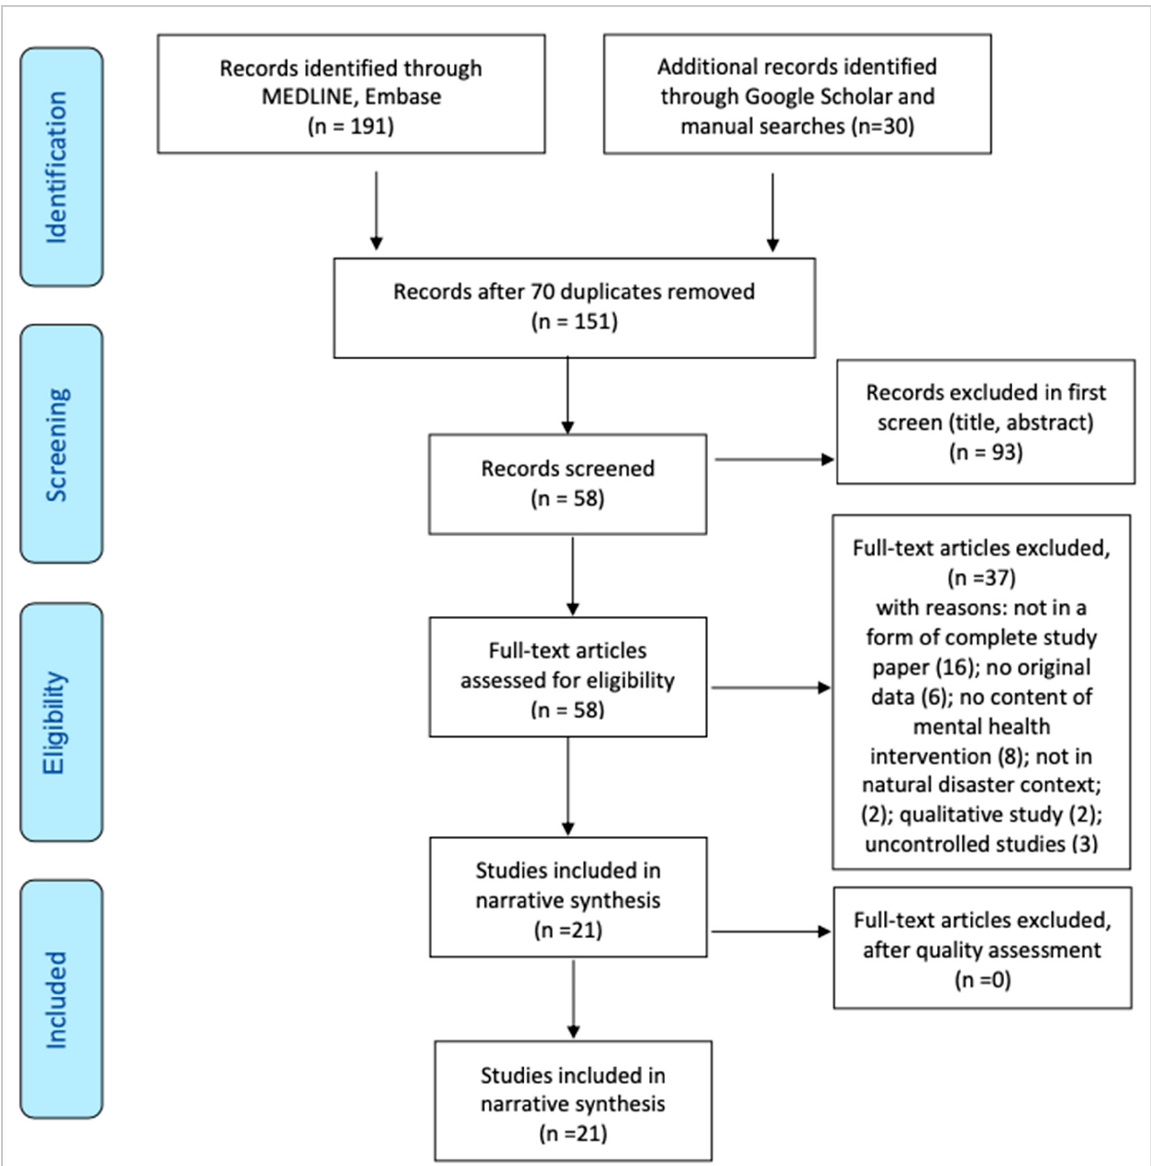
Figure 1. PRISMA Flow Diagram.